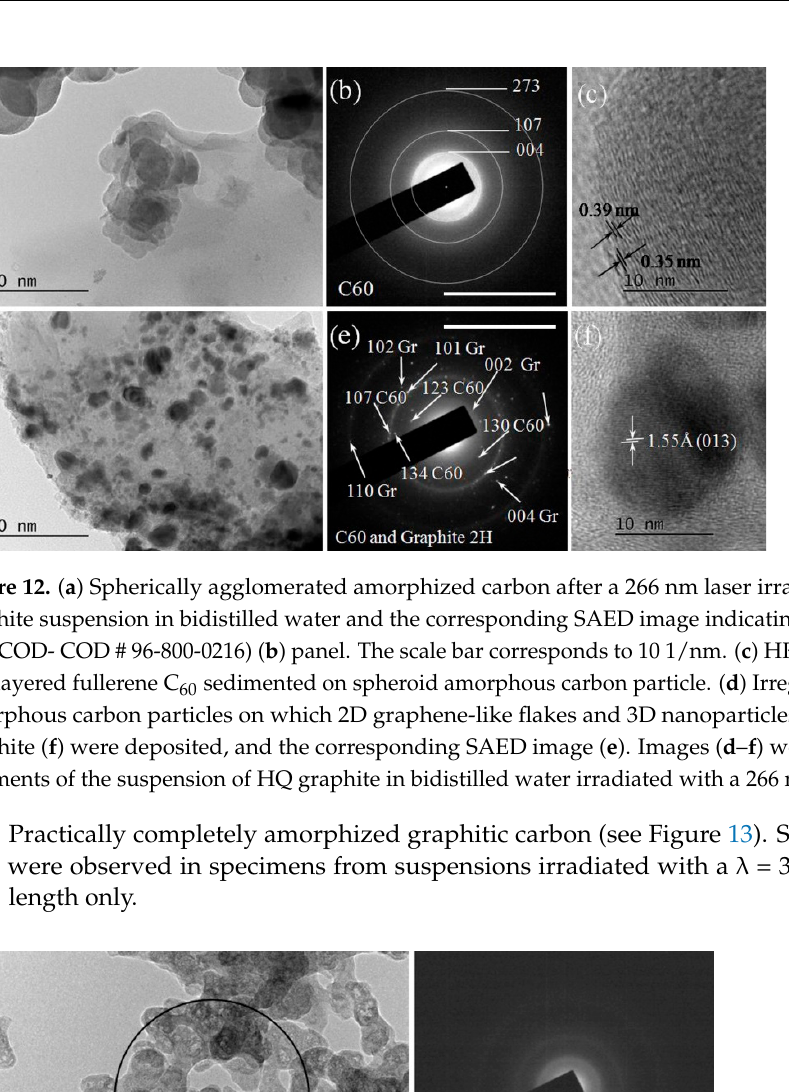
13 of 16 Figure 11. ( a ) An overview TEM image of LQ graphite irradiated with λ = 266 nm H 2 O, demon- strating a complex formation of few-layered graphene/defected graphene flakes agglomerated with 3D nanoparticles of C 60 fullerenes. ( b ) The SEAD pattern indicating the presence of the reflexes of hexagonal graphite and those of C 60 . The scale bar corresponds to 10 1/nm. ( c ) HRTEM of nano-sized 3D particles of C 60 with interplanar spacing varying between 0.28 and 0.30 nm. -